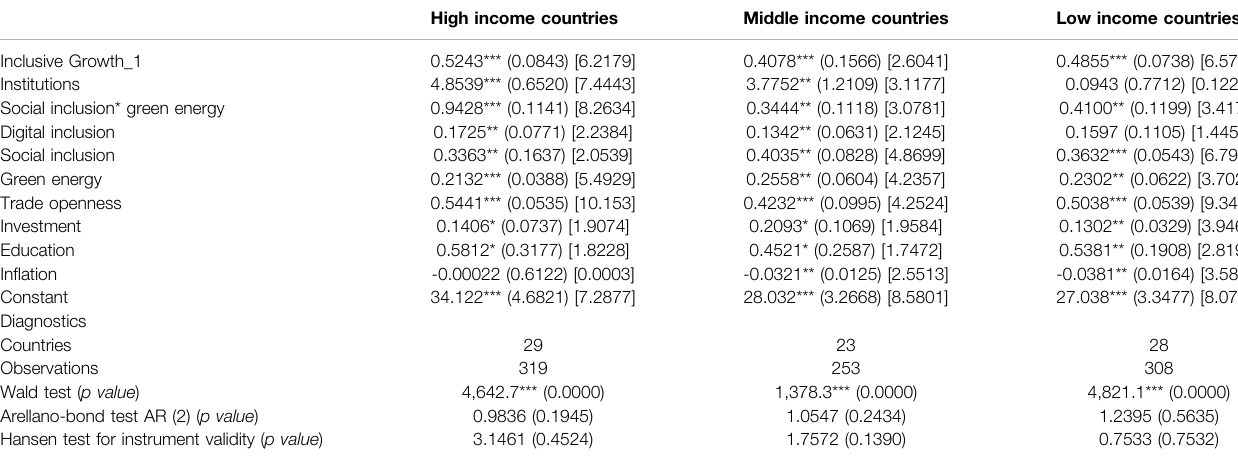
TABLE 2 | Results of social inclusion and green energy interaction.